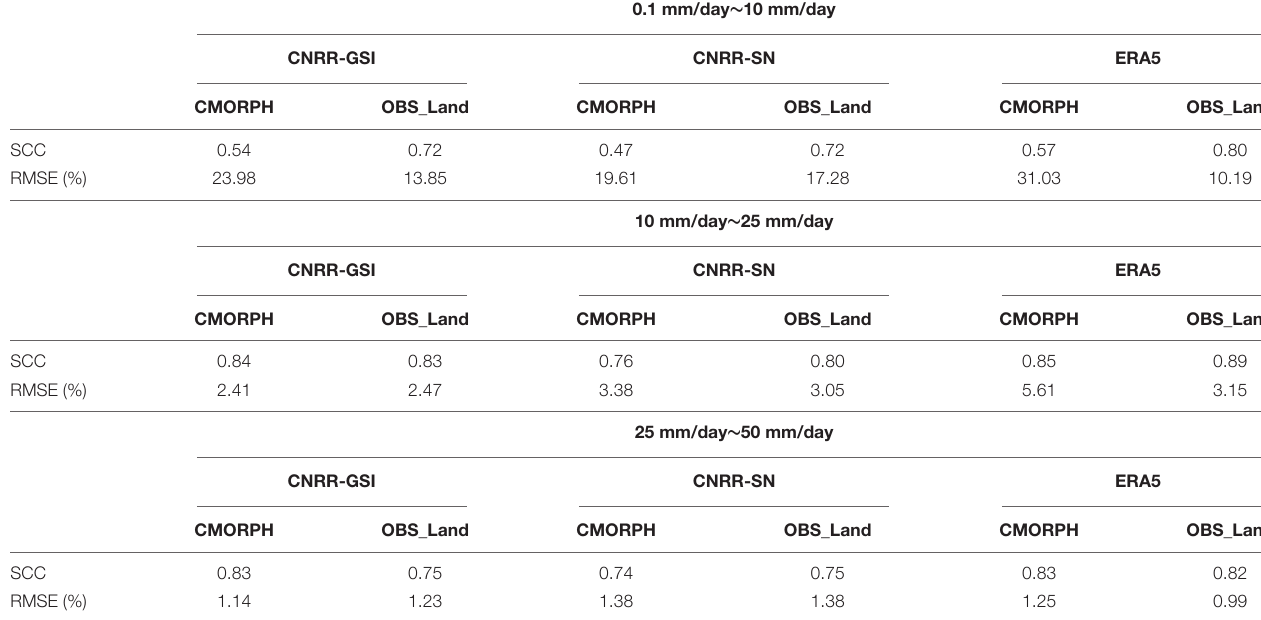
TABLE 3 | The SCCs and RMSEs of wet day probability for the three rainfall bands between CNRRs, ERA5 and observations.